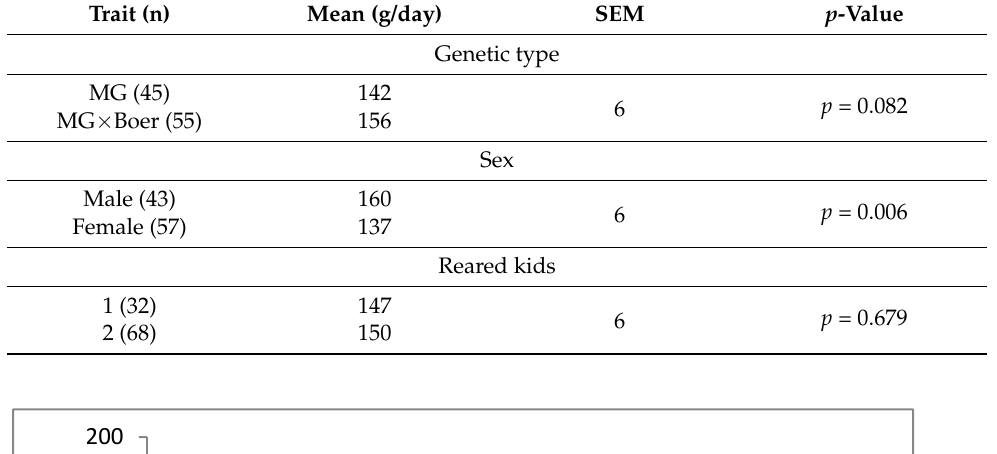
Figure 1. Evolution of unadjusted kids’ live weight according to their genetic type, in a mixed rearing system (MG = Murciano-Granadina; week 0 corresponds to the birth weight). Table 2. Mean values of the average daily gain associated with the effects of genetic type, sex of the kids and the number of reared kids, in a mixed rearing system (MG = Murciano-Granadina).